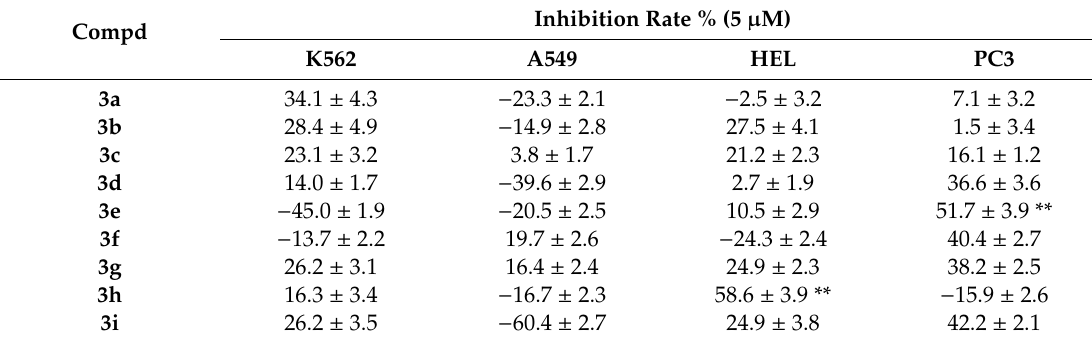
Table 2. The anti-cancer activities of the synthetic